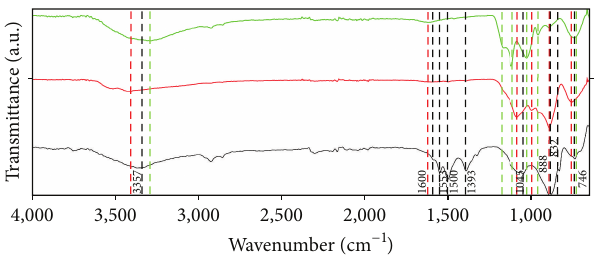
Figure 7: Infrared spectra of the as-grown ZnO-SiO 2 on glass sub- strate using 1.0M (black), 2.0 M (red), and 3.0 M (green) NH 4 OH.